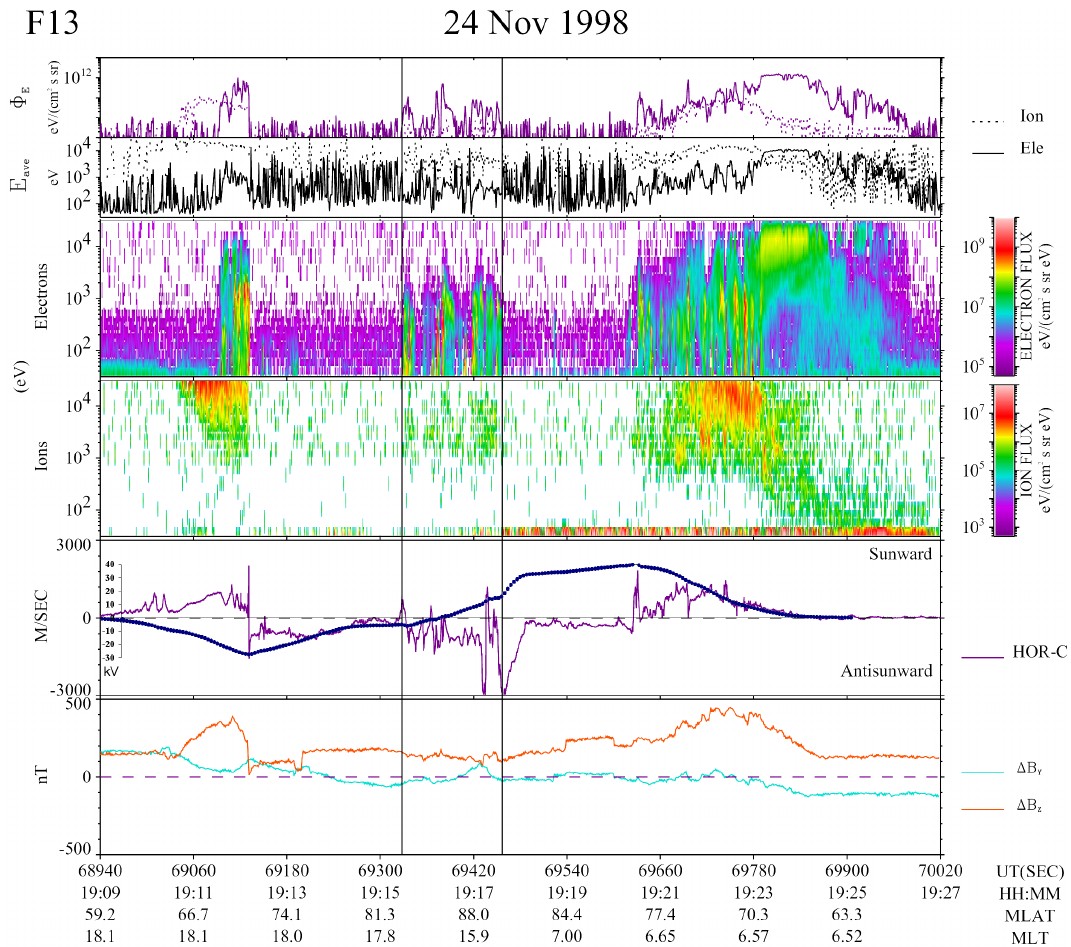
Fig. 3. DMSP F13 polar pass taken on 24 November 1998 in the dark Northern Hemisphere; same format as Fig. 1 except that because of the orbit geometry dusk is on the left hand side and dawn on the right. The satellite track is just 1 degree to the dayside of the dawn-dusk meridian and reaches 89 degrees magnetic latitude at the noon-midnight meridian. Same time as Fig. 5, second